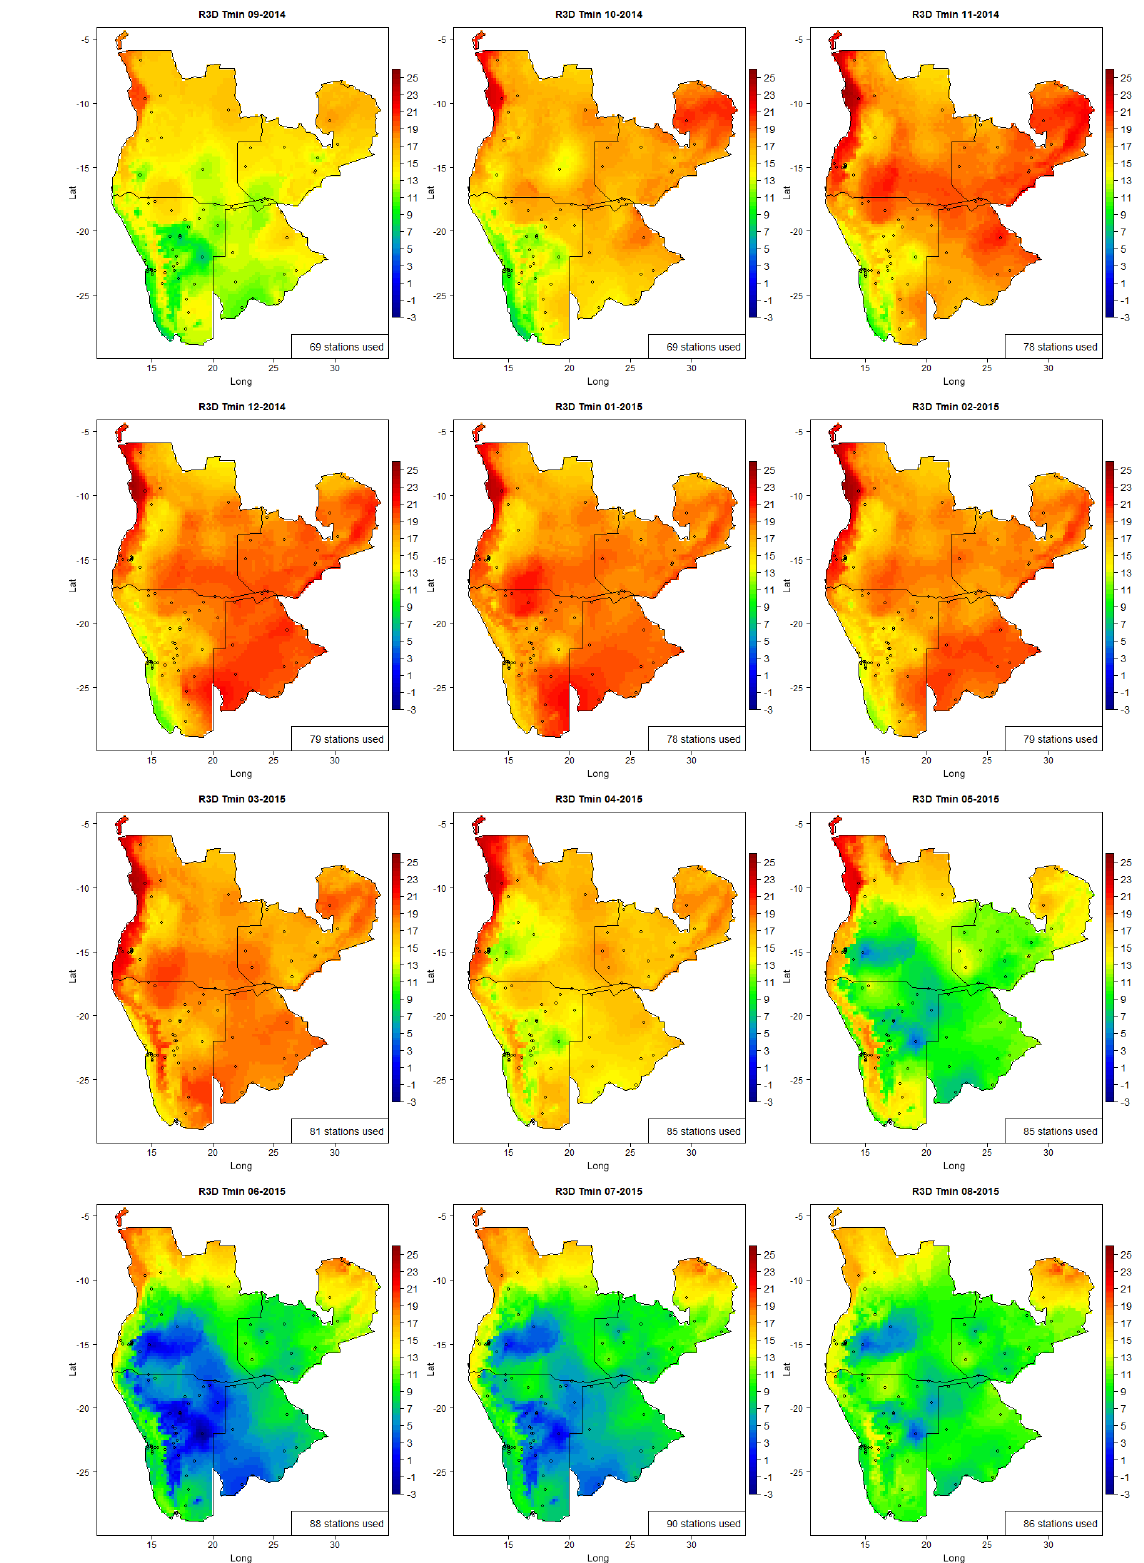
Figure 7. Minimum temperature maps on basis of three dimensional inverse distance weighting method from September 2014 until Au- gust 2015. Unit: ◦